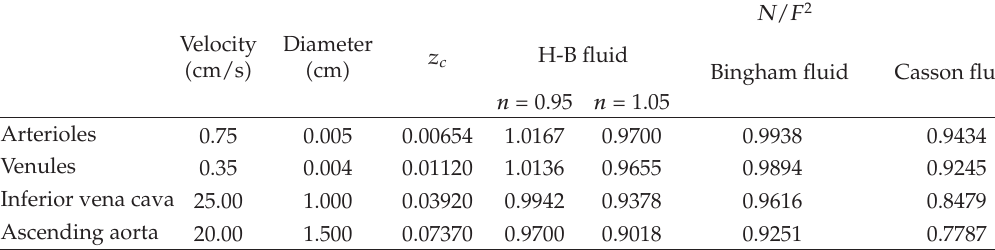
Table 2: Estimates of yield stress z c and relative di ff usivity (cid:2) N/F 2 (cid:3) in the canine vascular system for flow between parallel flat